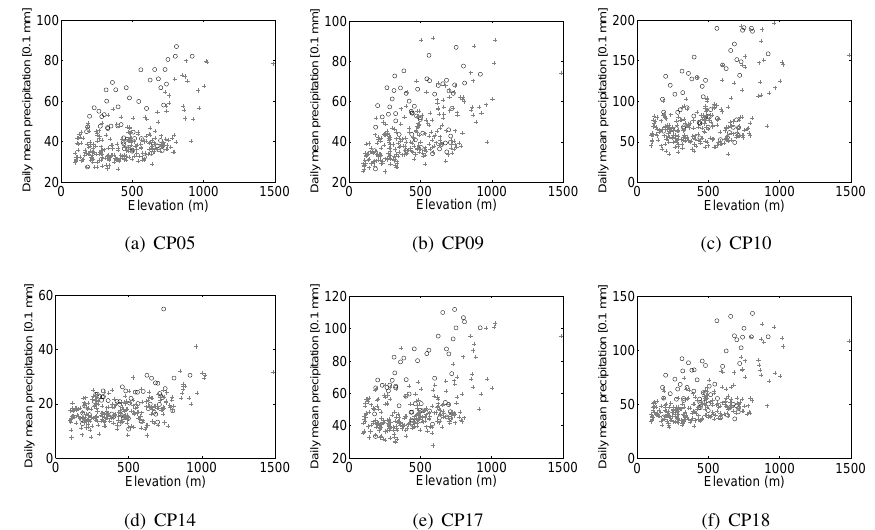
Fig. 12. Scatter plot of mean daily precipitation of wet CPs for BW (circles indicate valley stations, and crosses indicate non-valley stations, the trendlines are also shown in the figure).